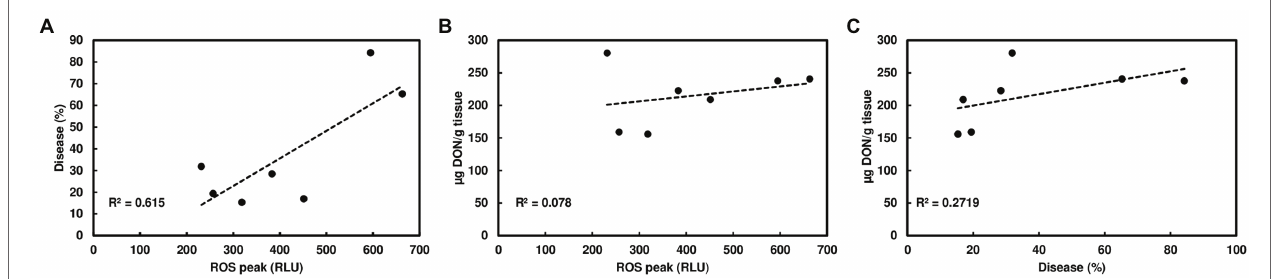
FIGURE 4 | Correlation analyses of ROS, FHB, and DON among different wheat varieties. (A) A positive correlation between chitin-triggered ROS in wheat rachis nodes and FHB severity; (B) No correlation between chitin-triggered ROS and DON content; and (C) No correlation between FHB severity and DON content. The FHB score was measured as the percentage of spikelets with bleach or necrosis symptoms at 21 dpi. DON was extracted from one to two infected spikelets and analyzed by GC/MS at 21 dpi. ROS were monitored using a chemiluminescence assay with L012 as a substrate. Chitin (100 μ g/ml) was used. ROS peaks (RLU) represent means ± standard error ( n = 36) from each